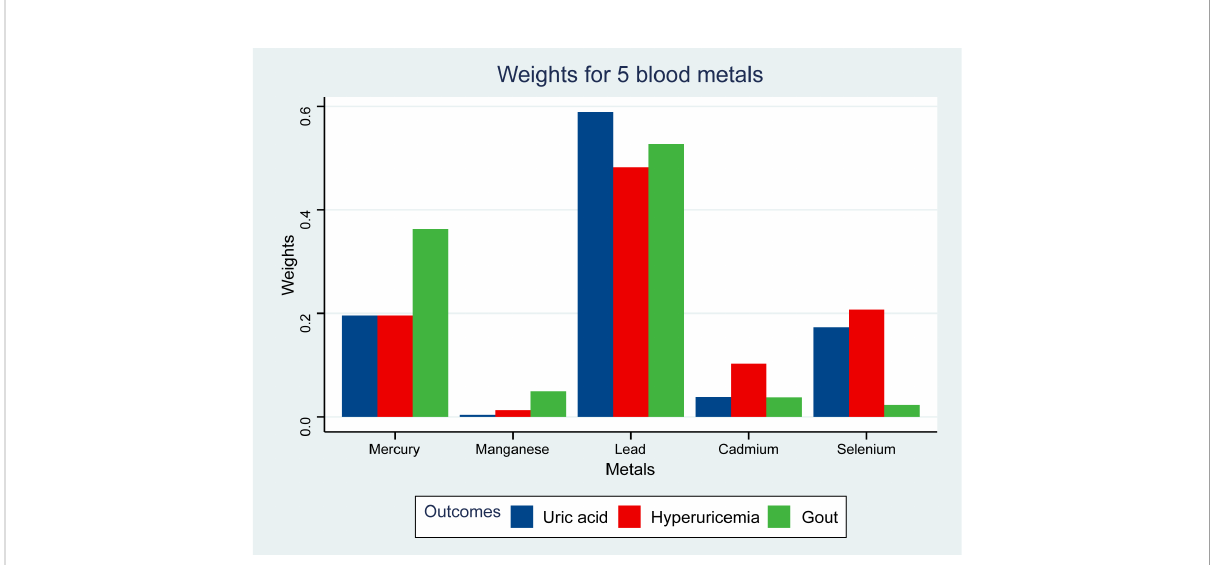
FIGURE 3 Weights from weighted quantile sum regression (WQS) for the blood metal mixtures and gout-related outcomes. Adverse model was adjusted for age, sex, education level, race, poverty, smoker, alcohol user, energy intake levels, sedentary time, BMI, total cholesterol, high-density lipoprotein cholesterol, eGFR, urinary creatinine, urinary albumin, diuretics, beta-blockers, diabetes, and